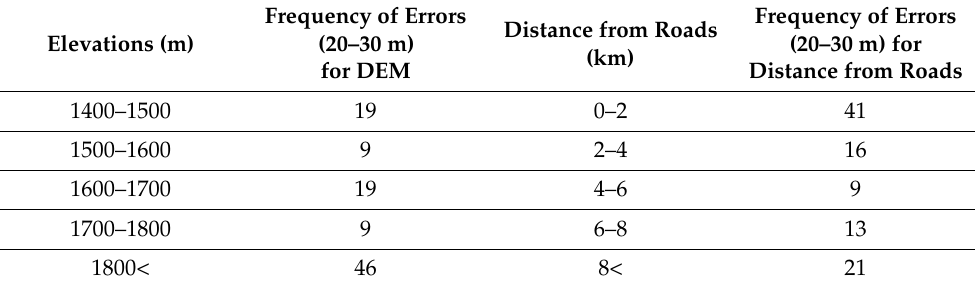
Table 4. Statistics of DEM and road map distance